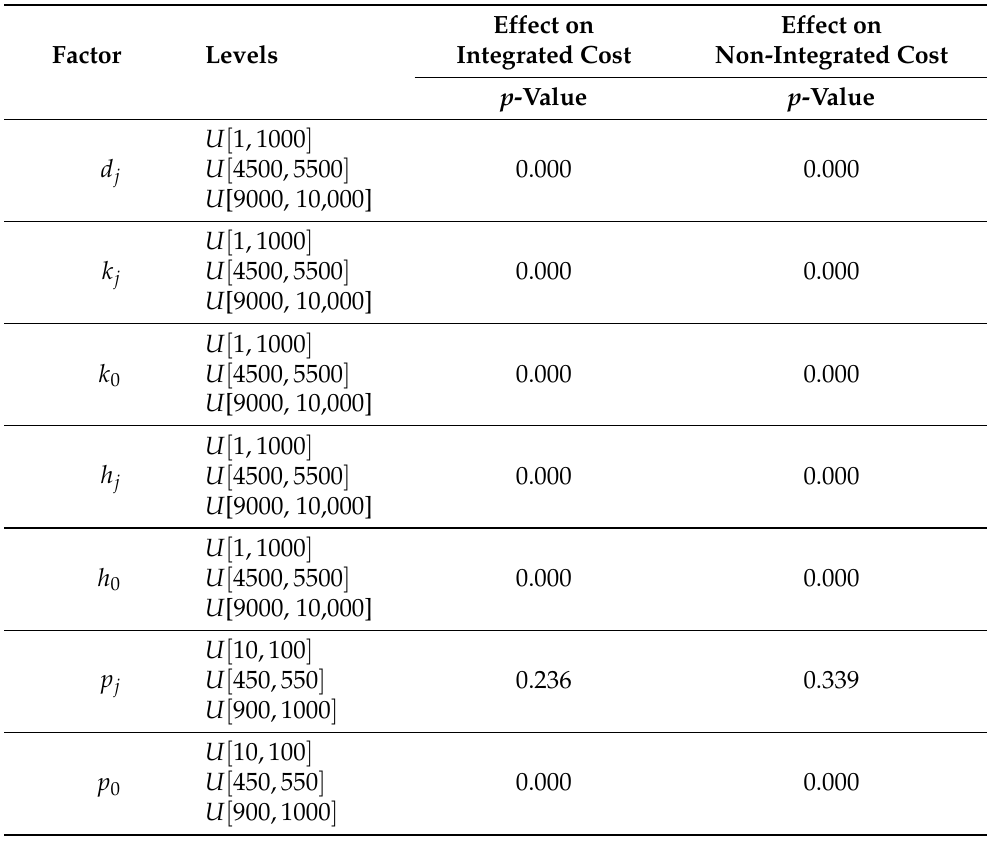
Table 9. The effects of the parameters d j , k j , k 0 , h j , h 0 , p j , and p 0 on the integrated and the non- integrated costs.